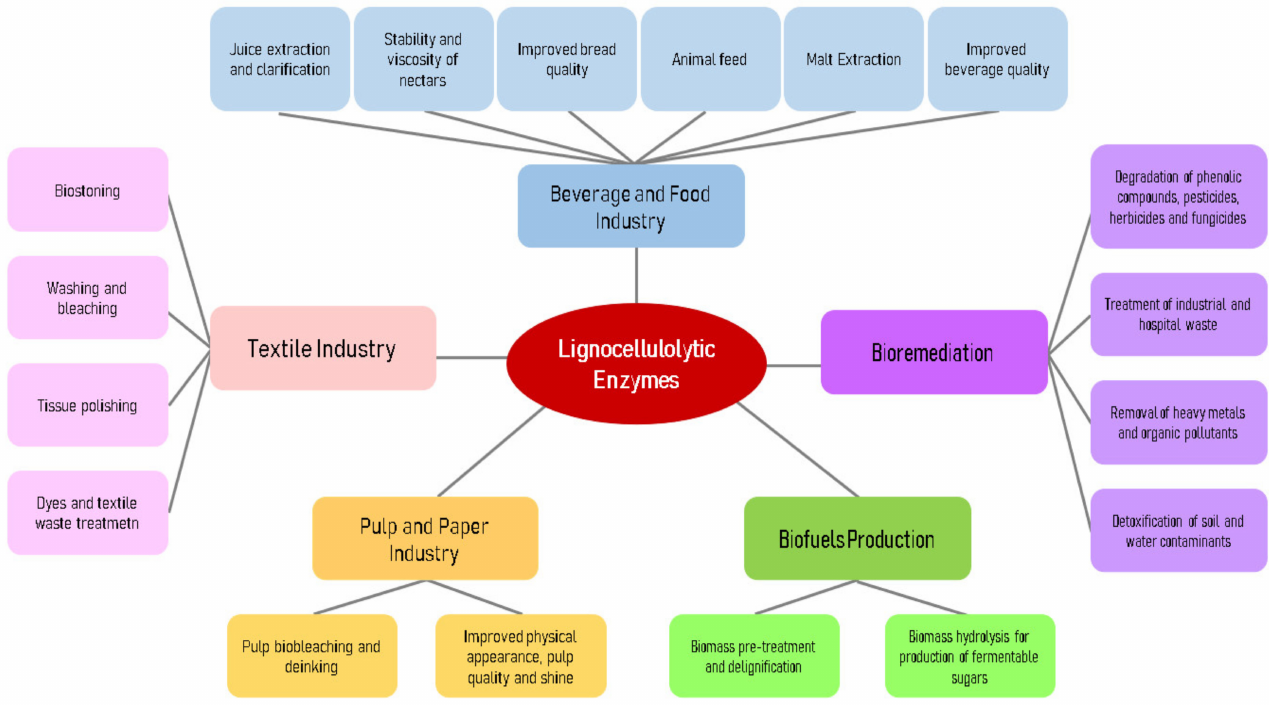
Figure 2. Different applications of lignocellulolytic